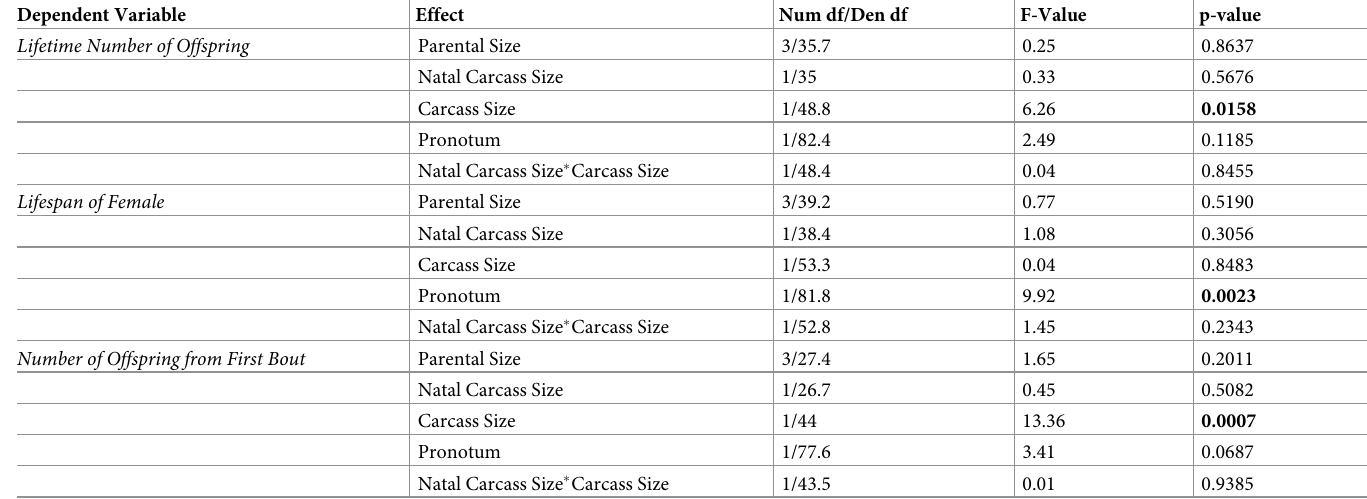
Table 1. Results of mixed model analysis of covariance for three fitness measures for N . marginatus .